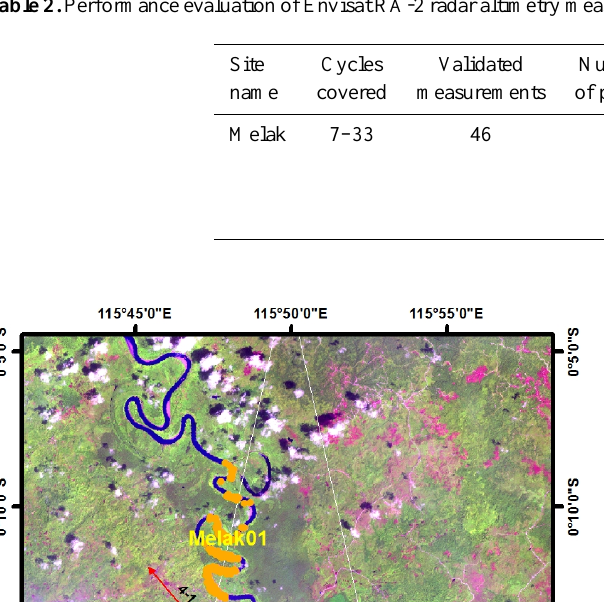
Table 2. Performance evaluation of Envisat RA-2 radar altimetry measurements over Melak virtual stations at Mahakam River (width 247m).